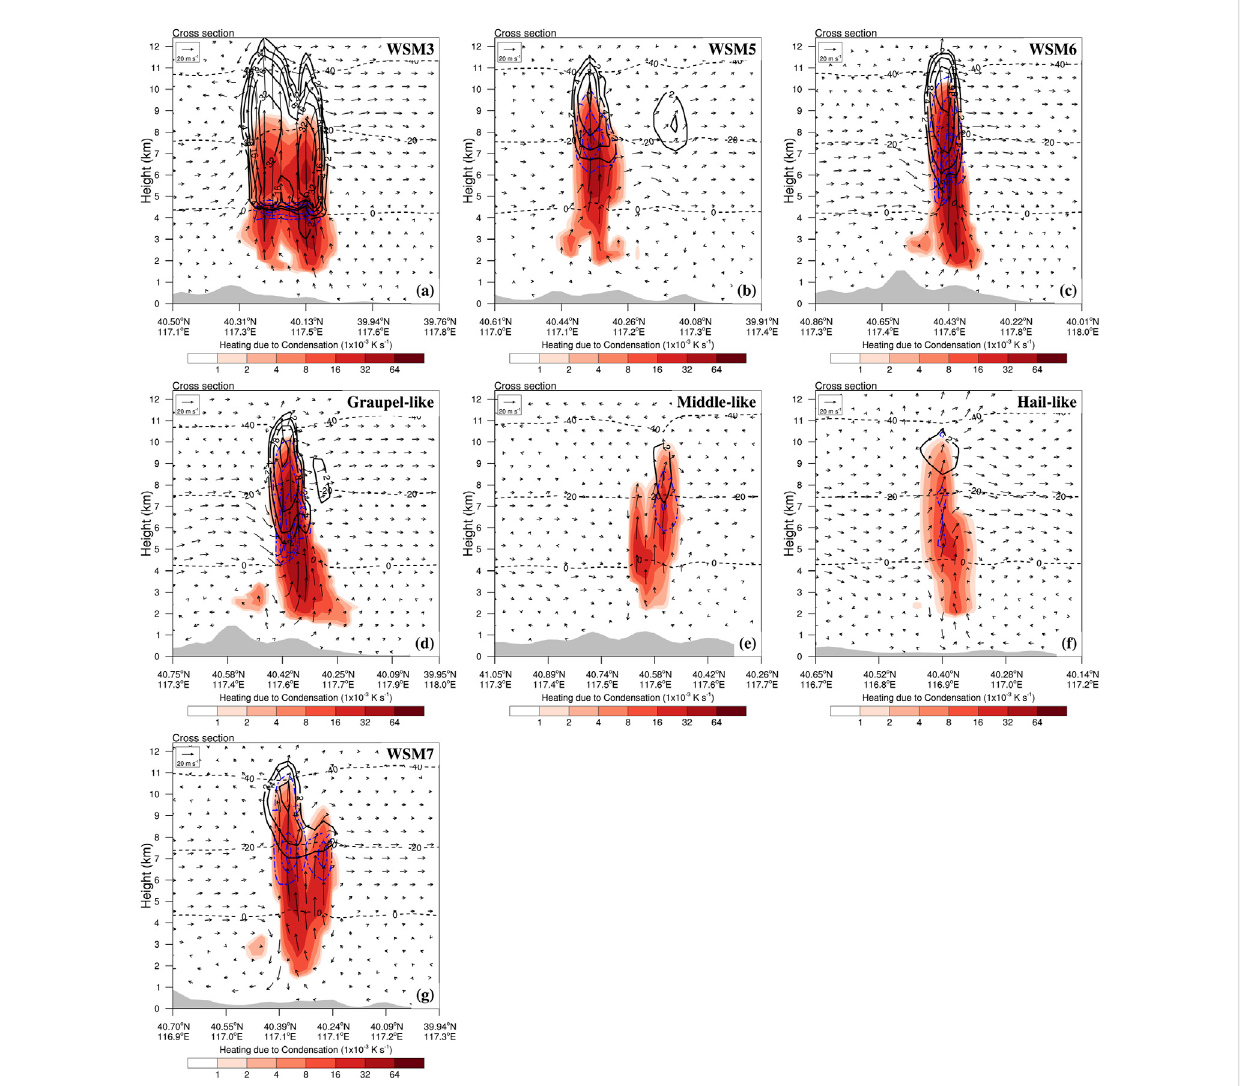
FIGURE 14 Verticalcross sections (along theblack lineinFigure 6)ofheatingsource fromcondensation(shaded; 10 − 3 Ks − 1 ),deposition (black solidlines; 10 − 3 K s − 1 )andfreezing (darkbluedashedlines;10 − 3 Ks − 1 )superimposedinstantaneous fl owwiththeisothermlines(blackdashedlines;Isoplethinterval is20 ° C) at convective development stage for all seven experiments: (A) WSM3, (B) WSM5, (C) WSM6, (D) WSM6-Graupel-Like, (E) WSM6-Middle-Like, (F) WSM6- Hail-Like and (G) WSM7 experiments. The grey areas indicate the terrain